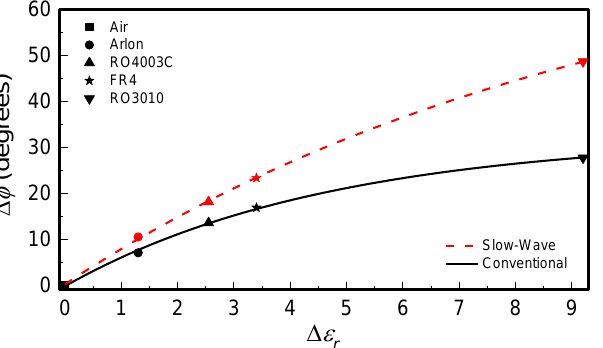
Figure 7. Dependence of the differential phase of the measured transmission coefficient at the op- erating frequency with the dielectric constant of the MUT. The differential phase is defined as = N MUT N air , where N MUT and N air are the measured phases obtained with MUT and air, re- spectively, and r = r , MUT r , air . Reprinted with permission from [61].